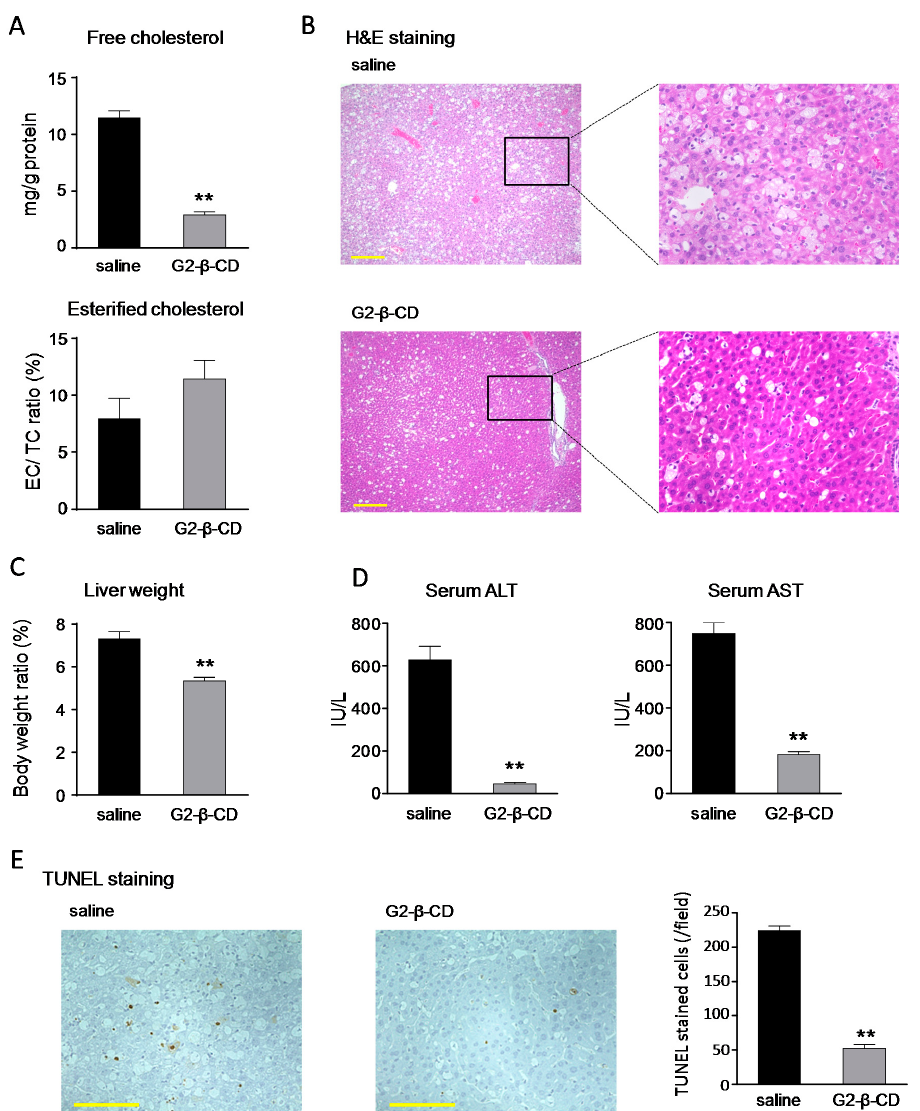
Figure 6. Attenuating effects of systemic G2- β -CD treatment on liver manifestations in Npc1 − / − mice. Mice were subcutaneously treated with G2- β -CD (2.9 mmol/ kg) from 6 to 8 weeks of age, and then serum and liver samples were collected at 8 weeks and 2 days of age. Free cholesterol (FC) content and percentage of esterified cholesterol (EC) in liver tissue ( A ), liver histological analysis (H&E) ( B ), Liver/body weight ratio ( C ), serum alanine aminotransferase (ALT) and aspartate aminotransferase (AST) levels ( D ) and hepatic DNA fragmentation (TUNEL staining) ( E ) were measured. Scale bar: 200 and 100 μ m for H&E and TUNEL staining, respectively. Each bar represents the mean ± S.E.M. ( n = 8). ** P < 0.01 compared with the saline group.